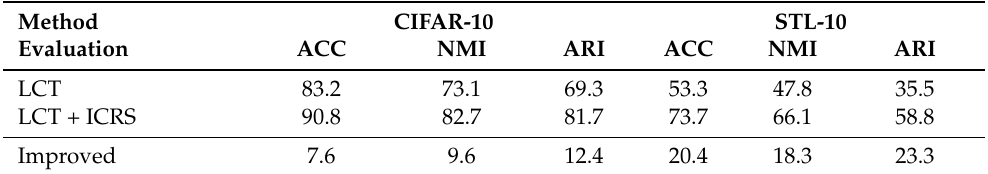
Table 5. ICSR improves clustering performances on models trained by the clustering-based represen- tation learning method. LCT is trained by representation learning method [30], and the backbone of the model is